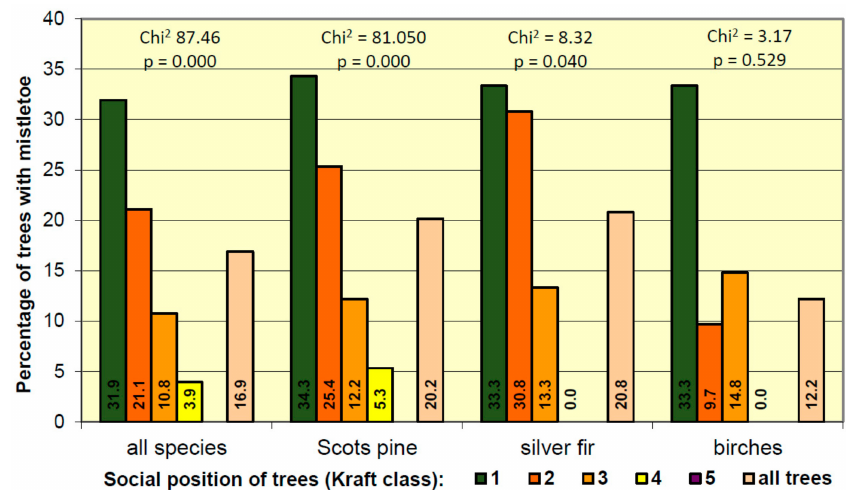
Figure 8. Percentage of trees with injuries caused by mistletoe in relation to social position (Kraft classes) of trees and the results of the χ 2 test for independence for all trees together (all species) and separately for species most infested by mistletoe (Scots pine, silver fir, and birches).